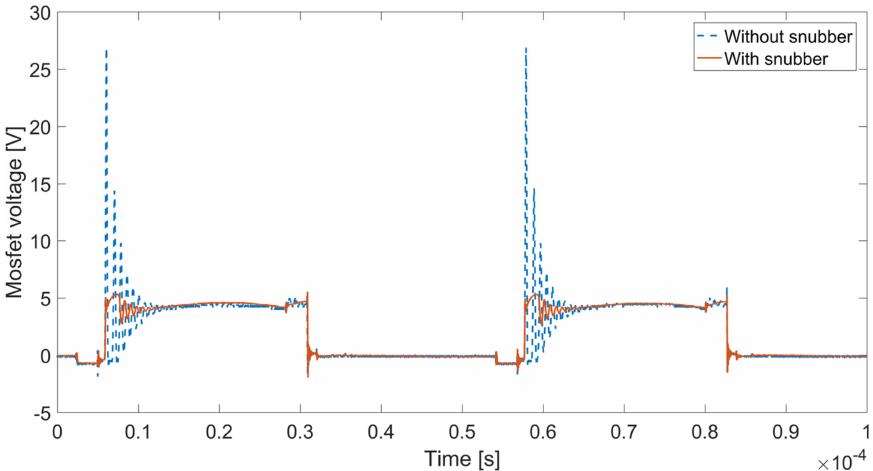
Figure 10. MOSFET voltages without (dashed blue line) and with (continuous red line) the snubber